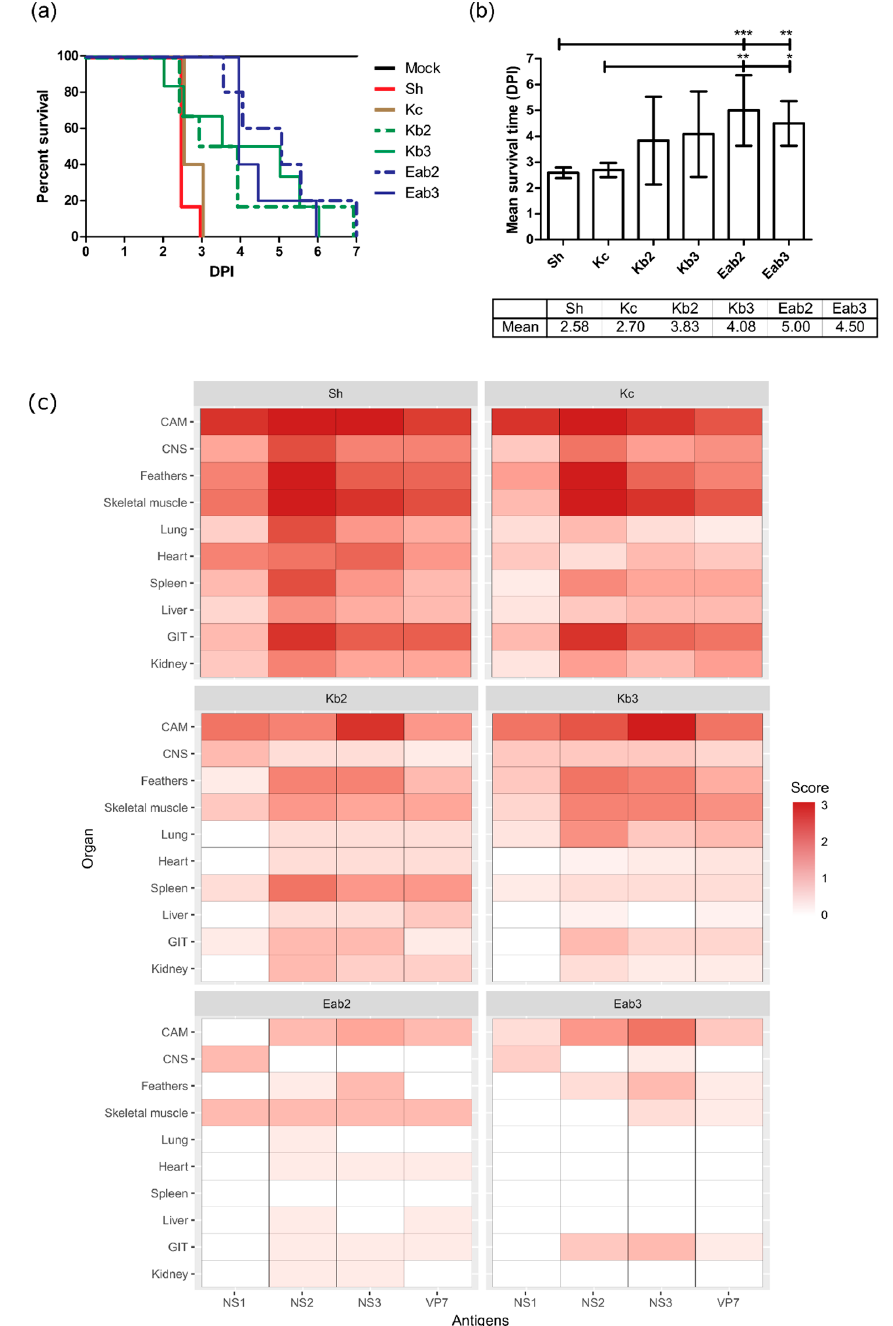
Figure 8. Survival curves ( a ) and mean survival times ( b ) of the ECEs infected with sheep blood BTV (Sh) and cell-culture-passaged BTV (Kc, Kb2, Kb3, Eab2, Eab3). Statistical analysis was performed using ANOVA followed by Bonferroni multiple-comparison test. * p < 0.05, ** p < 0.01, *** p < 0.001. The viral antigen loads from tissues collected at clinical endpoint were assessed semi-quantitatively by light microscopy at 40 × magnification, and the average scores for each organ were plotted as heat maps ( c ). Scores: 3 = abundant, 2 = moderate, 1 = minimal, 0 = undetectable. CAM = chorioallantoic membrane; CNS = central nervous system; GIT = gastrointestinal tract. Kb = KC/BHK-BSR; Eab = ECE/ Aedes /BHK-BSR.